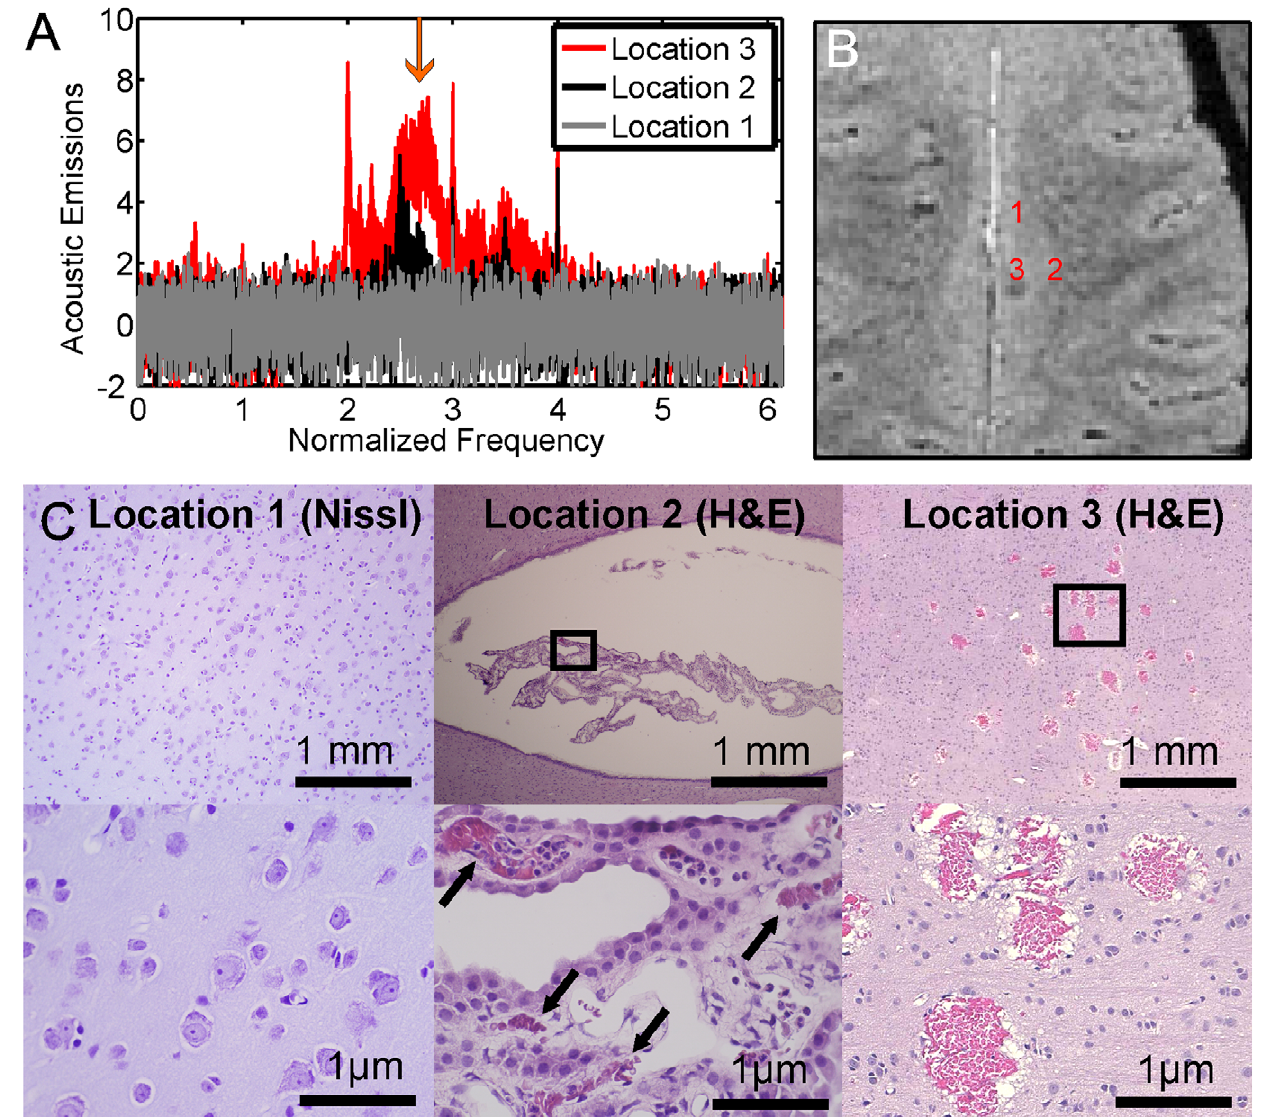
Figure 3. Acoustic emissions, MRI, and histology at different exposure levels. (A) Acoustic emissions, recorded during three single-target sonications delivered to the cingulate cortex in monkey # 2, showing the largest broadband emissions for these sonications (arrow). Only locations 2 and 3 exhibited strong harmonic emissions (harmonic signal strength: 4.1, 17.9 and 25.8 Np ? Hz, for locations 1–3, respectively) and resulted in contrast enhancement in MRI. Broadband emissions with an SNR greater than 3 were present at location 3 and at a much lower level at location 2, but not at location 1. The estimated pressure amplitudes in the brain were 175 kPa at location 1 and 275 kPa at locations 2–3. (B) T2*-weighted image acquired shortly after the sonications. A hypointense spot is only evident at location 3. (C) Light microscopy showing no petechaie or other changes at location 1. Tiny petechaie were found in the choroid plexus, (in the lateral ventricle) which was just inferior to location 2. It is possible that any changes in MRI resulting from petechaie at this location were missed because they occurred in the ventricle, which appears hypointense in our T2*-weighted imaging. Extensive petechaie were evident in histology at location 3. These petechaie covered a region 3 mm in diameter, similar to the half-intensity beam width of the focal zone of this TcMRgFUS